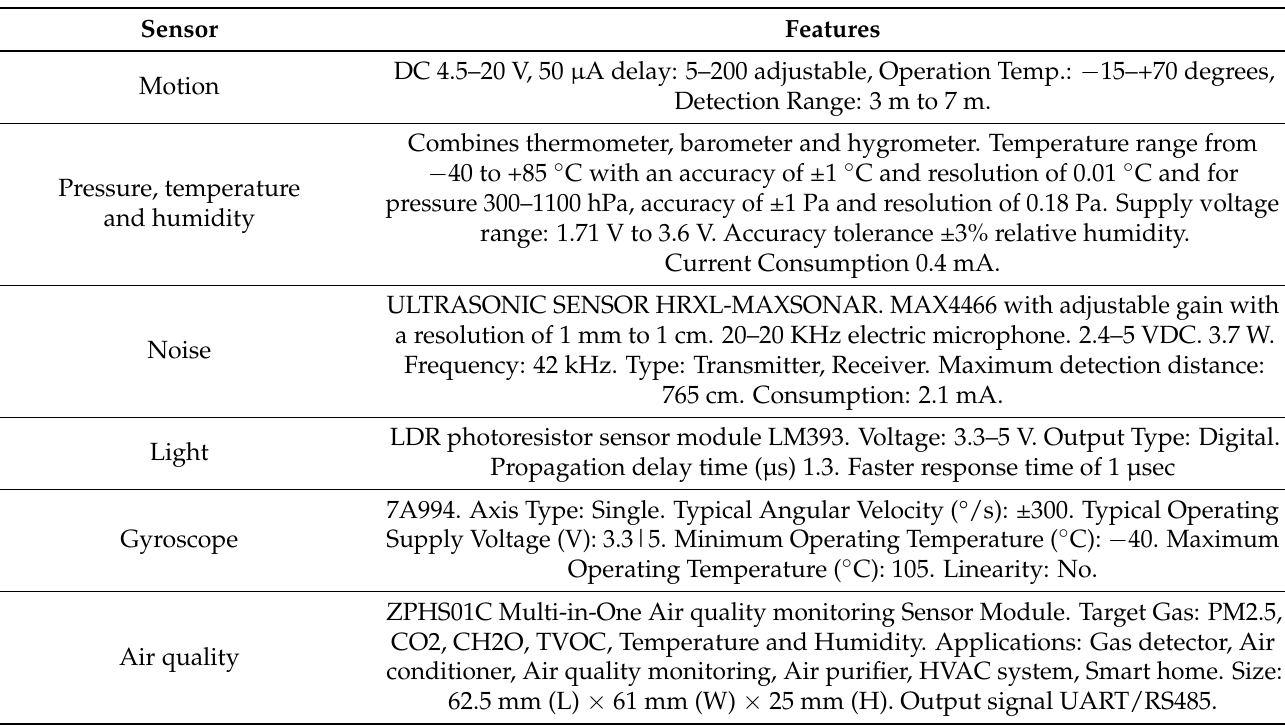
Table 2. System network technical